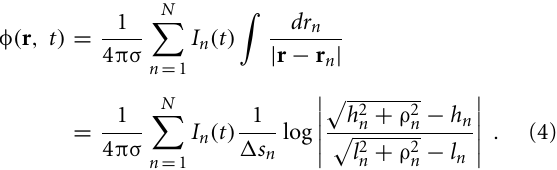
FIGURE 2 | Illustration of biophysical modeling scheme and corresponding organization of LFPy -package. (A) Principle of multicompartmental modeling where a piece of an apical dendritic branch, in this example assumed purely passive with only capacitive and leak membrane currents, is divided into a set of compartments indexed by n . The circuit diagram shows the equivalent electric circuit of the compartment where the dynamics is governed by an equation set consisting of equations of the type shown in Equation (1). The net transmembrane current I n ( t ) , in this case the sum over the capacitive and leak membrane currents in